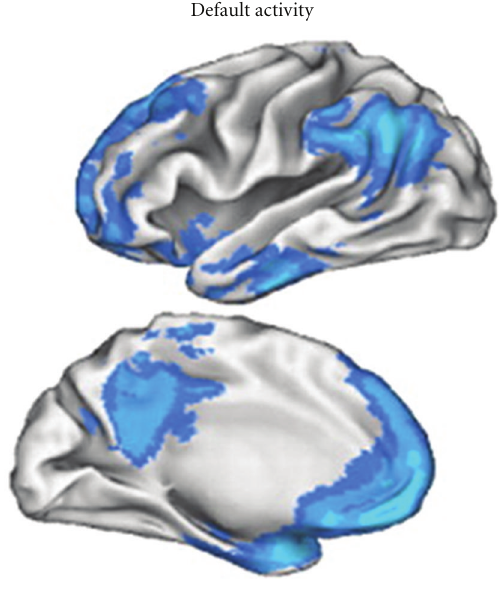
Figure 1: The brain’s default network was originally identified in a meta-analysis that mapped brain regions more active in passive as compared to active tasks (often referred to as task-induced deacti- vation). The displayed [O-15]H 2 O positron emission tomography (PET) data include nine studies (132 young adults) from Shulman et al. [30] (reanalyzed in [21]). Images show the medial and lateral surface of the left hemisphere using a population-averaged surface representation to take into account between-subject variability in sulcal anatomy. Blue represents regions most active in passive task settings. Adapted and reprinted with permission from Buckner et